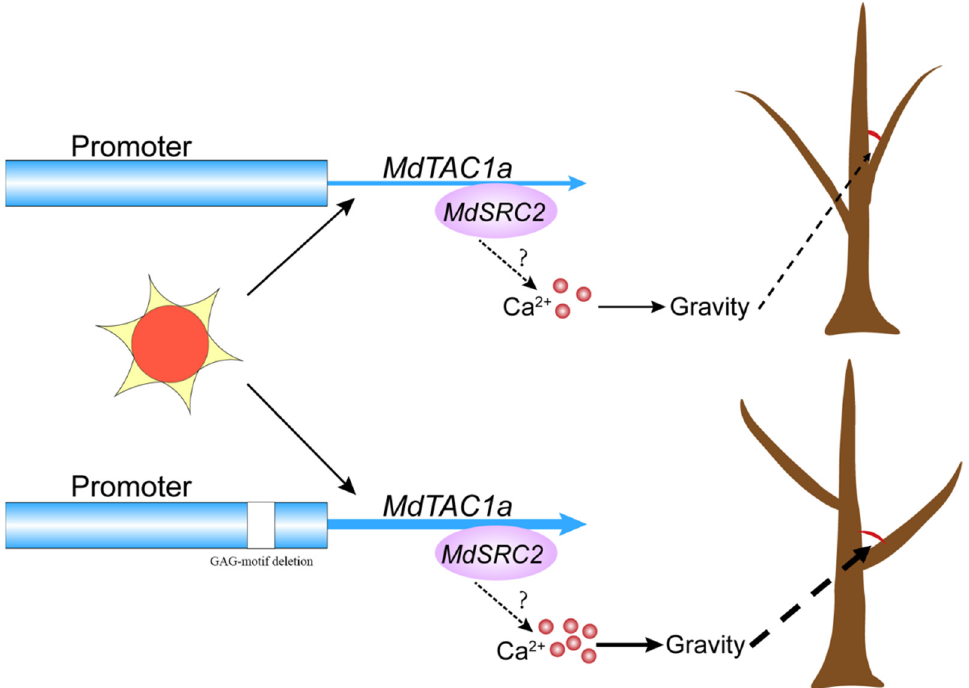
Figure 11. The model of MdTAC1a in regulating the branching angle of apple trees. In apple MdTAC1a interacts with MdSRC2 to affect intracellular Ca 2+ concentration remains to be proven.